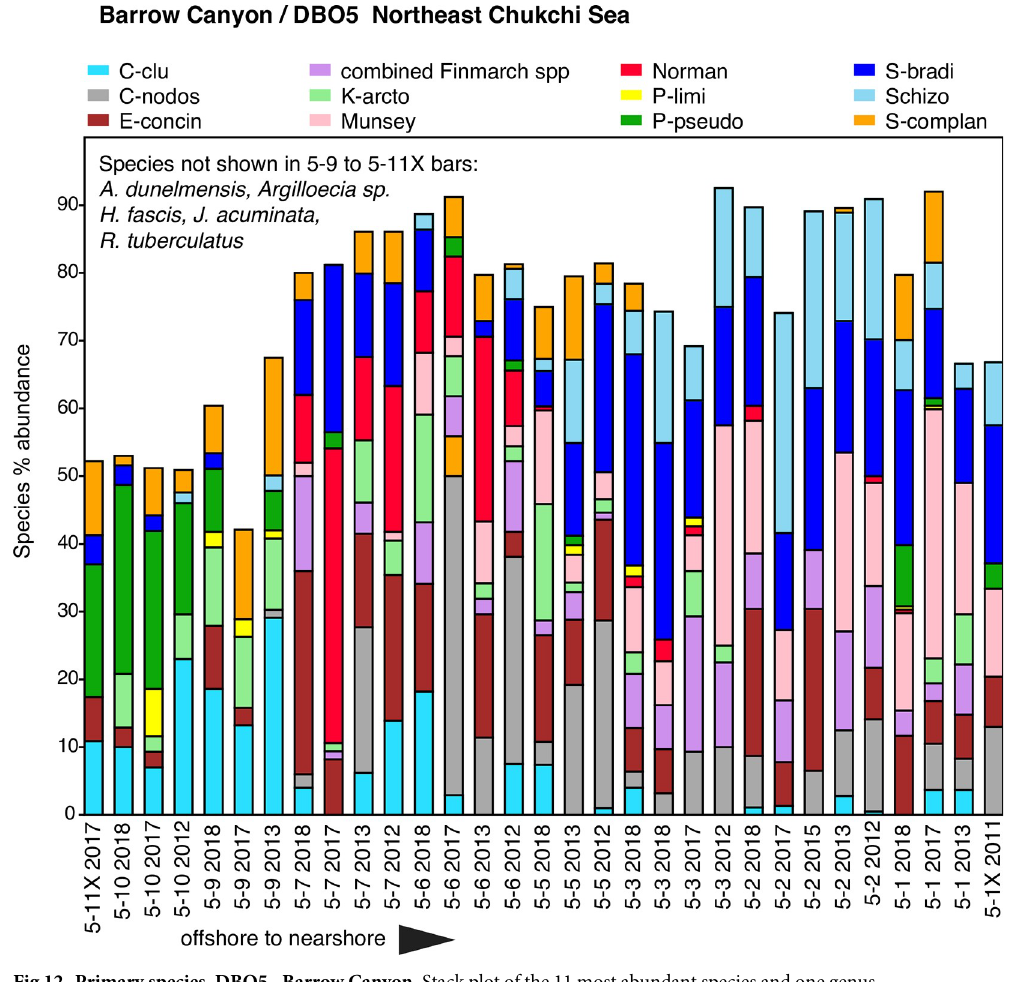
Fig 12. Primary species, DBO5 –Barrow Canyon. Stack plot of the 11 most abundant species and one genus ( Finmarchinella ), comprising ~80% of the ostracode assemblage, in DBO5-Barrow Canyon region (sites on Fig 2 map) from years ranging from 2011 to 2018 (n = 31 surface sediment samples with � 30 specimens/sample, 2,951 total specimens). Other faunas at stations 5–9 and 5–10 that account for the species not shown on the stack plot include A . dunelmensis , J . acuminata and H . fascis , and R . tuberculatus